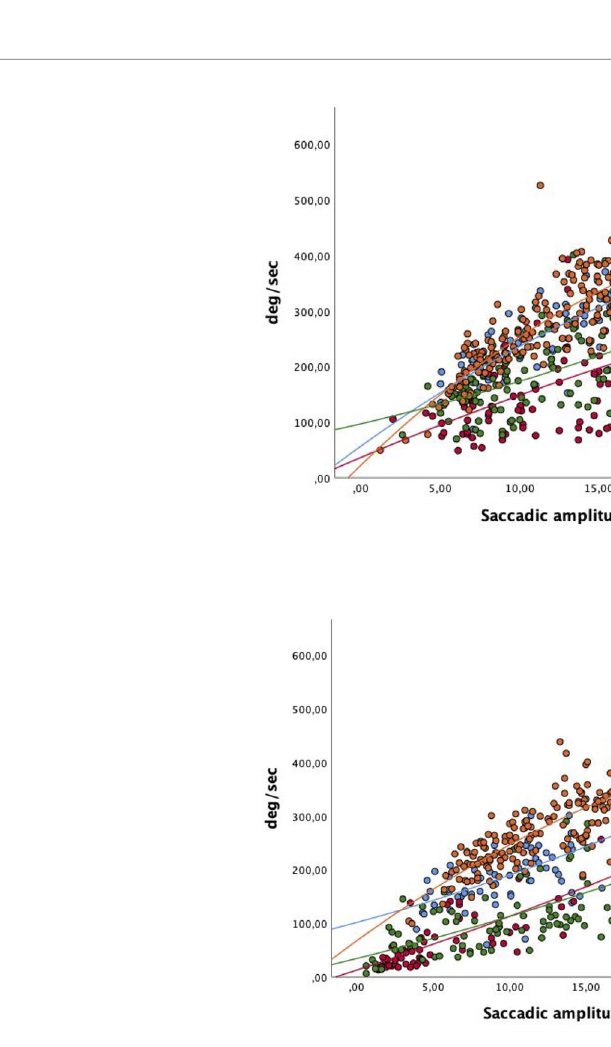
FIGURE 1 | Plot of relationship between saccade amplitude and velocity for horizontal and vertical saccades; signi fi cant results p= <0.01 are marked with *. Spearman ’ s rho is noted in the